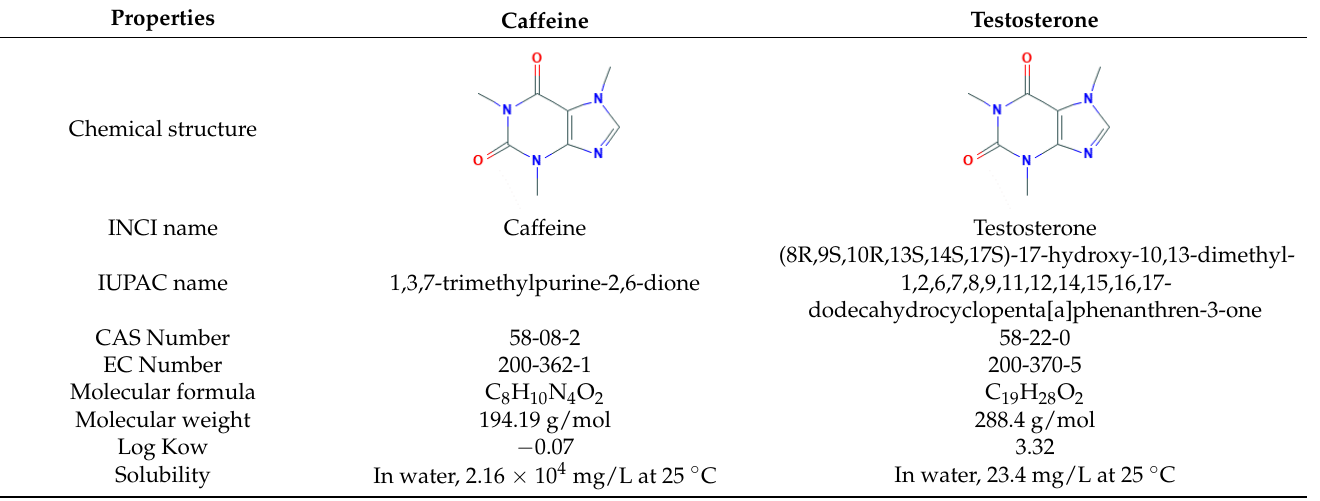
Table 1. Physicochemical properties of caffeine and testosterone.